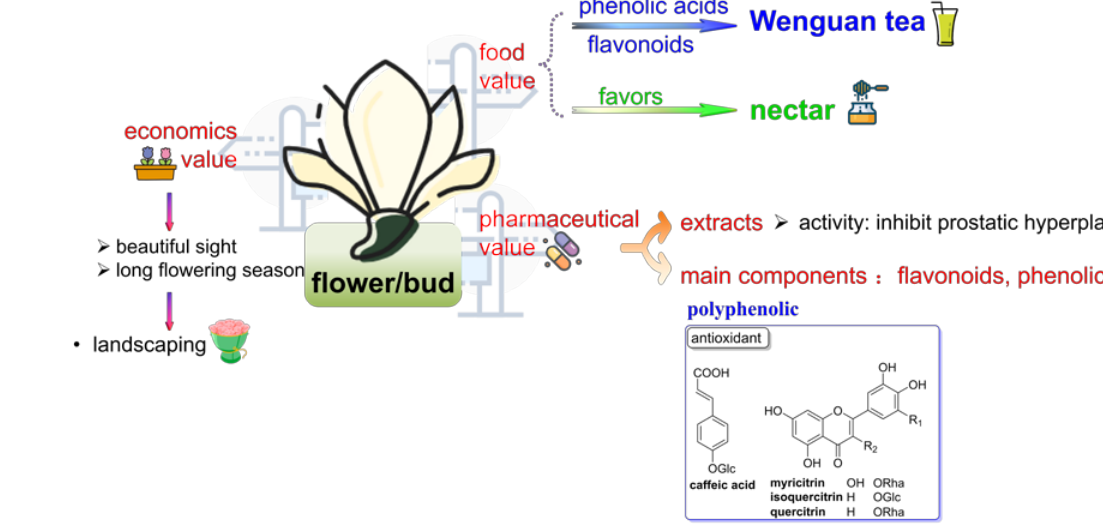
Figure 4. The uses of flower/bud of X.